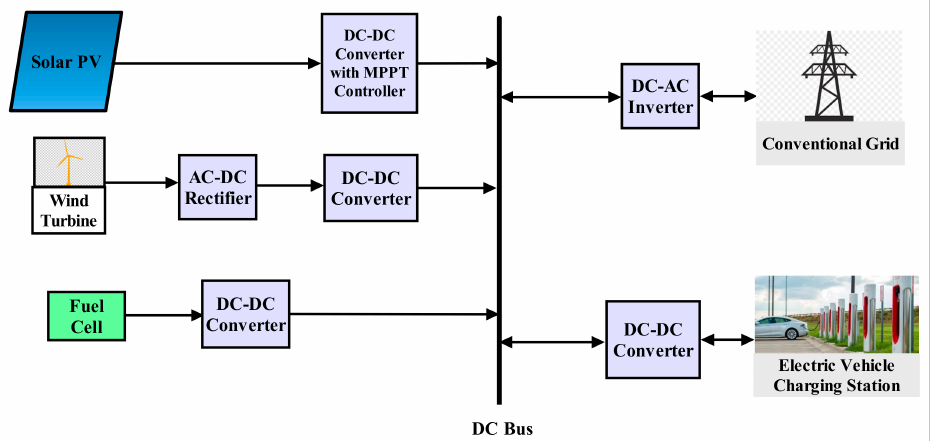
Figure 1. Structure of DC MG integrated with